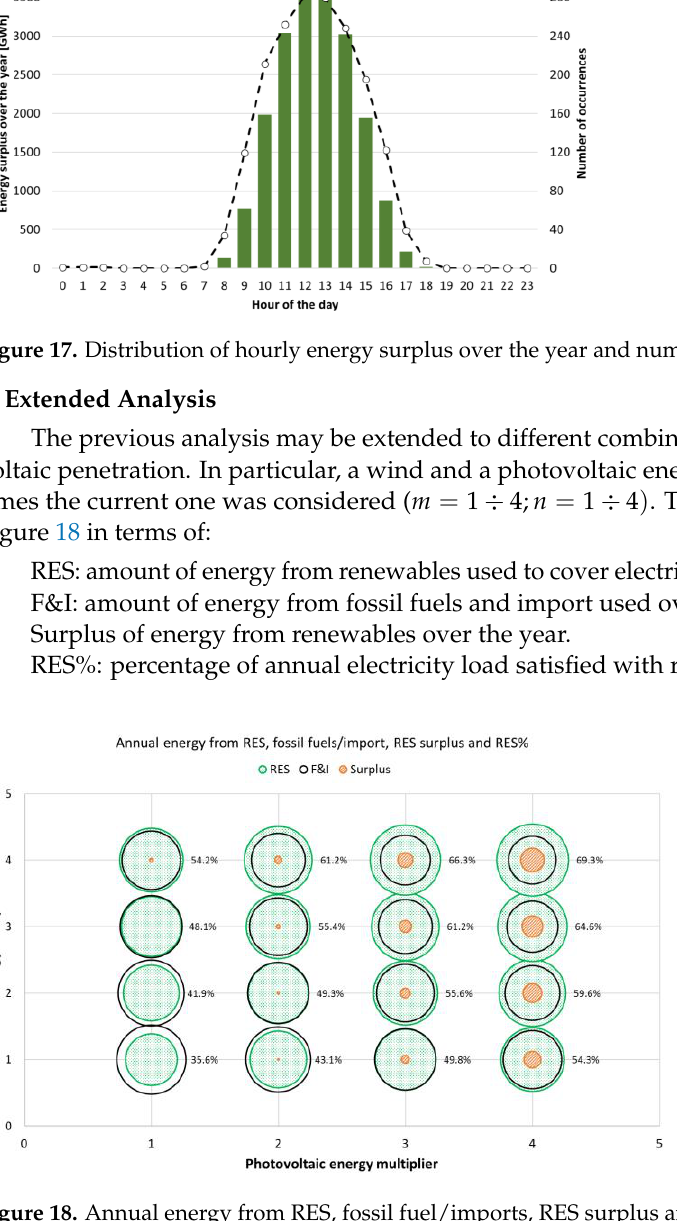
Figure 16. Distribution of hourly averaged power over the year of surplus users in Case 2.